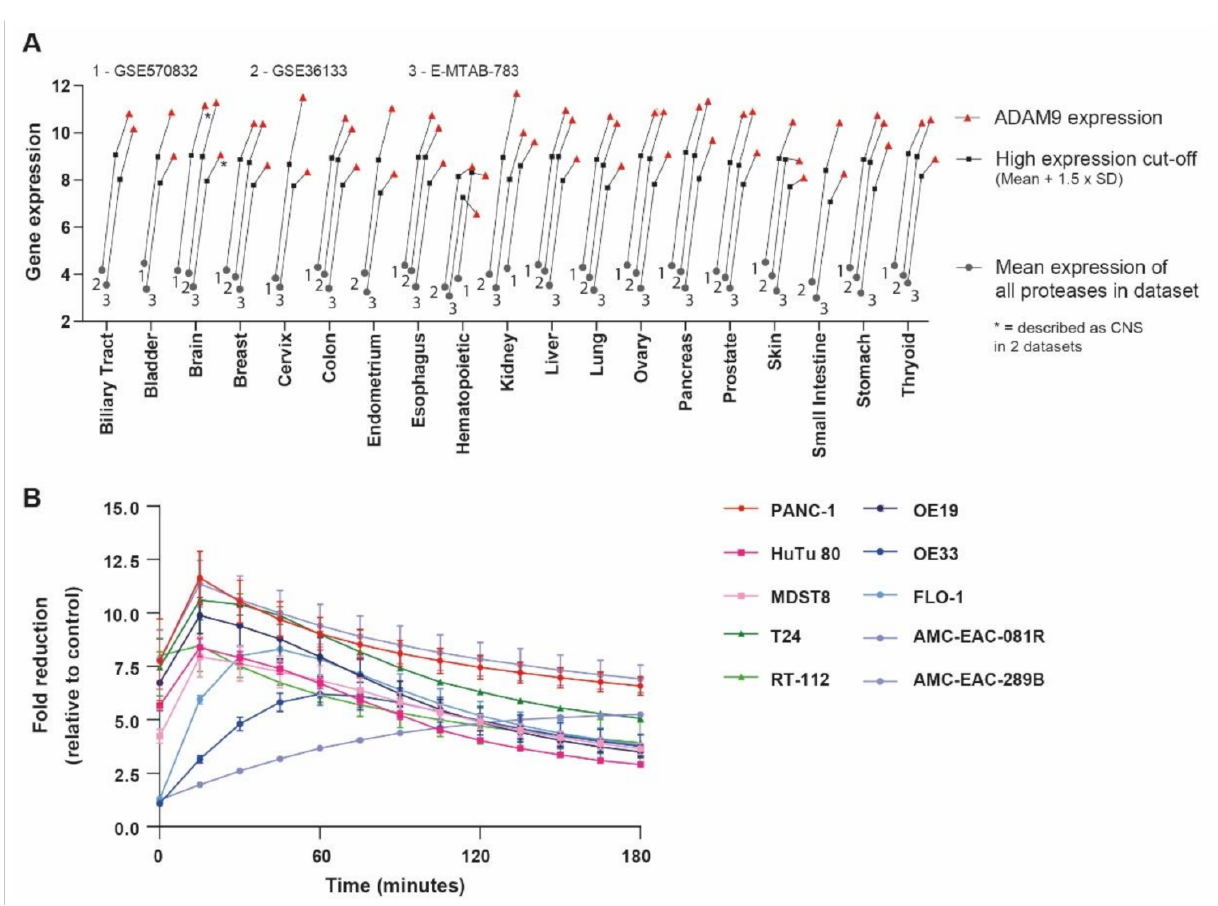
Figure 5. ADAM9-MSNs may be applied to multiple cancer types. ( A ) Average ADAM9 expression in multiple cell lines of several cancer types. Gray circles represent the calculated average expression of all proteases per organ in the large sets of cancer cell lines (GSE36133, GSE57083, and E-MTAB-783); black squares represent the ‘high expression’ cut-off, determined as average protease expression × 1.5 times the standard deviation; red triangles indicate the ADAM9 expression levels. ( B ) ADAM9-substrate cleavage by conditioned media collected from several cancer cell lines. Data are the mean of three experiments performed in